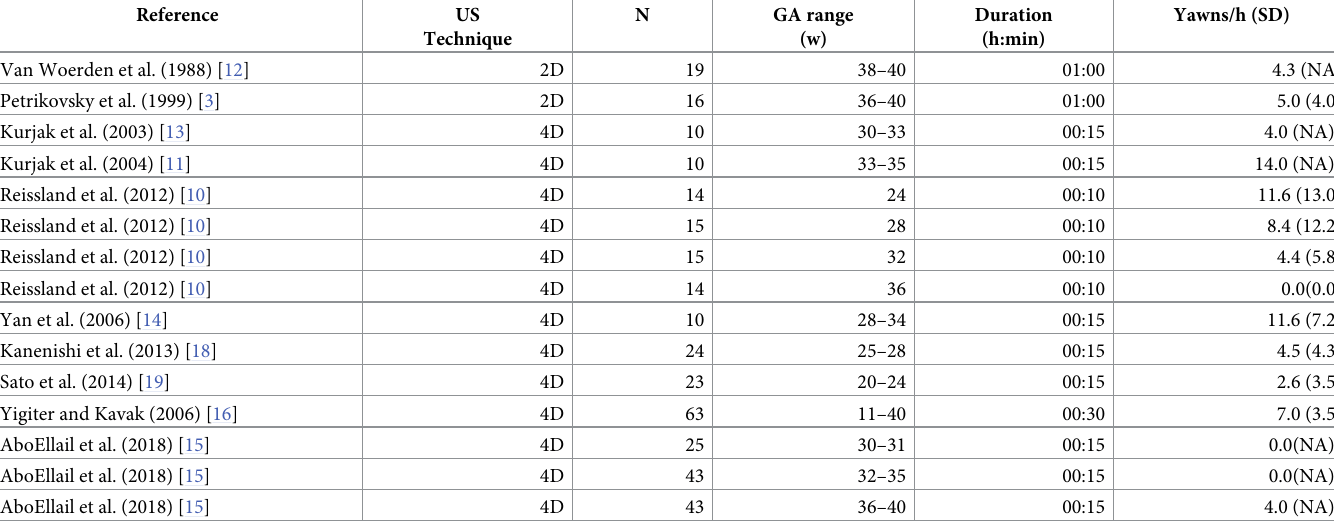
Table 1. Spontaneous yawning frequencies of healthy fetuses.